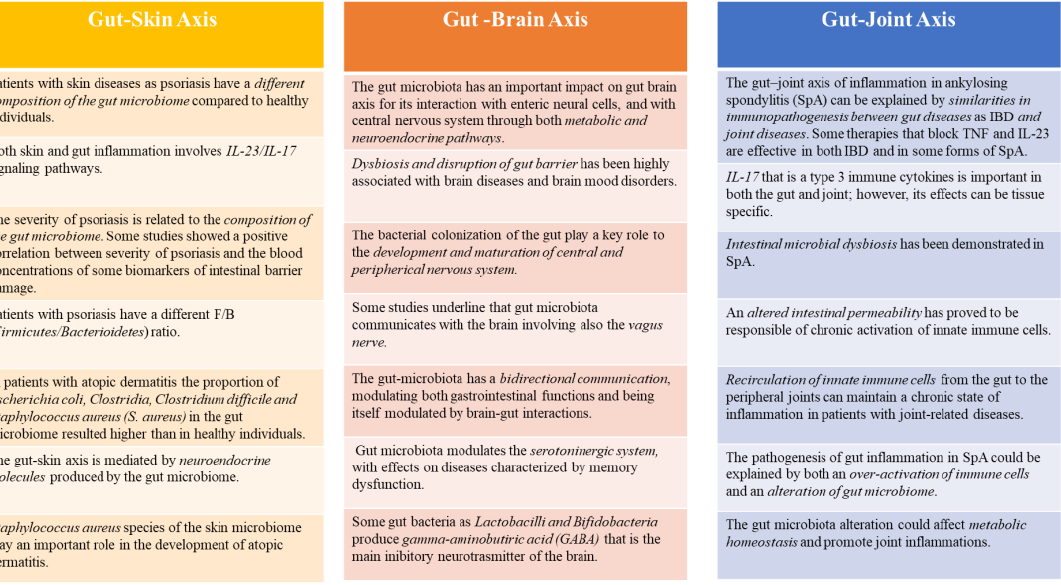
Figure 2. Gut-Skin, Gut-Brain, Gut-Joint Axis and the role of fecal calprotectin. Faecal calprotectin , as a marker of gut inflammation, can be very useful for clinicians in both intestinal and non-intestinal diseases, due to the link between gut and other systems as skin, brain,